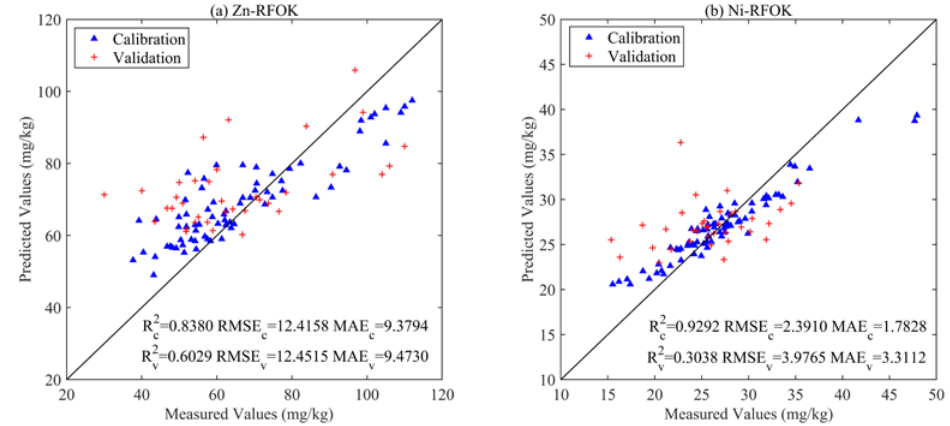
Table 2. Heavy metal concentrations map accuracy evaluation. Element Figure 8. Scatter plots for the optimum inversion models. (Note: ( a , b ) represent Zn and Ni, respectively). Figure 8. Scatter plots for the optimum inversion models. (Note: ( a ) and ( b ) represent Zn and Ni, respectively.)